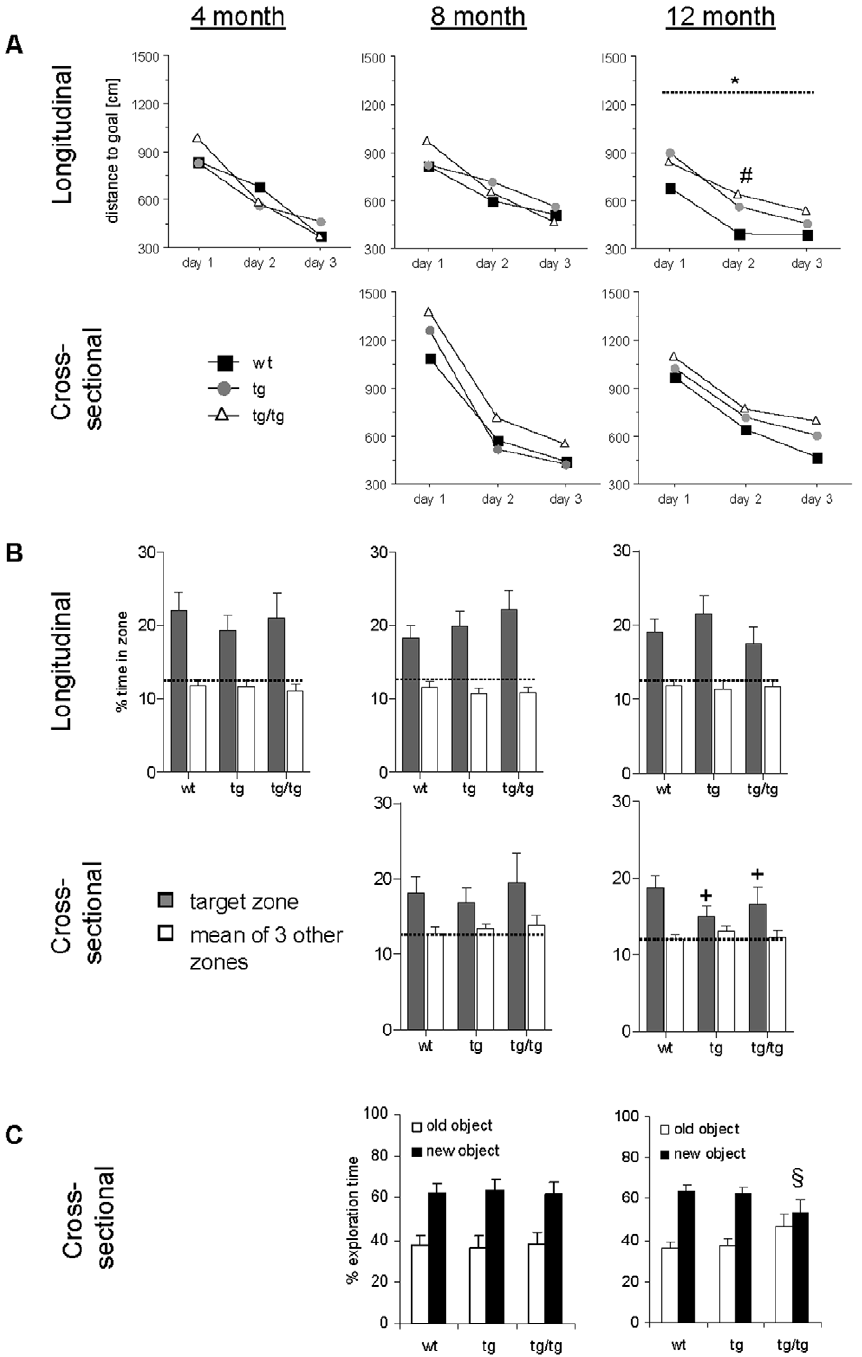
Figure 6. Learning and memory of ARTE10 mice in behavioral tests. A , In the water maze task 12 months old ARTE10 mice from the longitudinal cohort are impaired in spatial learning. Animals were trained to learn the position of a hidden escape platform in the water pool. In the longitudinal study animals were tested repeatedly every 4 months until they reach 12 months of age. In the cross sectional study design different testing groups with naı¨ve animals were used at each time point. Each data point represents the mean of 6 trials per animal. (*) p=0.0407 between groups over days (repeated measures ANOVA); ( # ) wt v/s tg/tg, p=0.0154 (unpaired t-test). B , After completion of the water maze training memory for the platform position in the target zone was assessed during a probe trial in which the platform was removed from the pool. For each group the percentage time in target zone (filled bar) is shown in comparison to the mean percentage time for the other three zones (open bar). ( + ) # 12.5%, tg, p=0.052; tg/tg, p=0.052 (one sample t-test). Data are expressed as means + SEM. Dotted lines represent chance levels (12.5%). C , Performance of mice in the object recognition test. Naı¨ve homozygous ARTE10 mice display deficits in episodic memory at 12 months of age as demonstrated by lacking preference for a new over an old object. Preference for the new object (filled bar) is expressed as percentage exploration time in comparison to exploration of the old object (open bar). Data are expressed as means + SEM. ( $ ) # 50%, tg/tg, p=0.293 (one sample t-test); tg, hemizygous transgenic mice; tg/tg, homozygous transgenic mice; Wt, wild type litter mates.